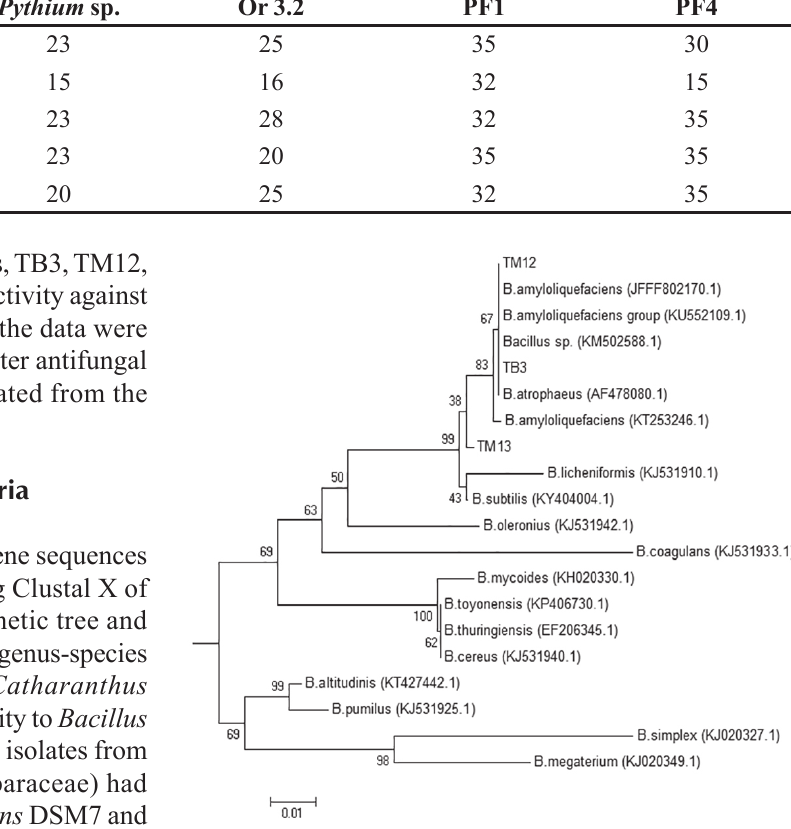
FIGURE 1 - Evolutionary relationships of taxa. The evolutionary history was inferred using the Neighbor-Joining method. The optimal tree with the sum of branch length = 0.36747719 is shown. The percentage of replicate trees in which the associated taxa clustered together in the bootstrap test (1000 replicates) are shown next to the branches. The tree is drawn to scale, with branch lengths in the same units as those of the evolutionary distances used to infer the phylogenetic tree. The evolutionary distances were computed using the Maximum Composite Likelihood method and are in the units of the number of base substitutions per site. The analysis involved 20 nucleotide sequences. All positions containing gaps and missing data were eliminated. There were a total of 363 positions in the final dataset. Evolutionary analyses were conducted in